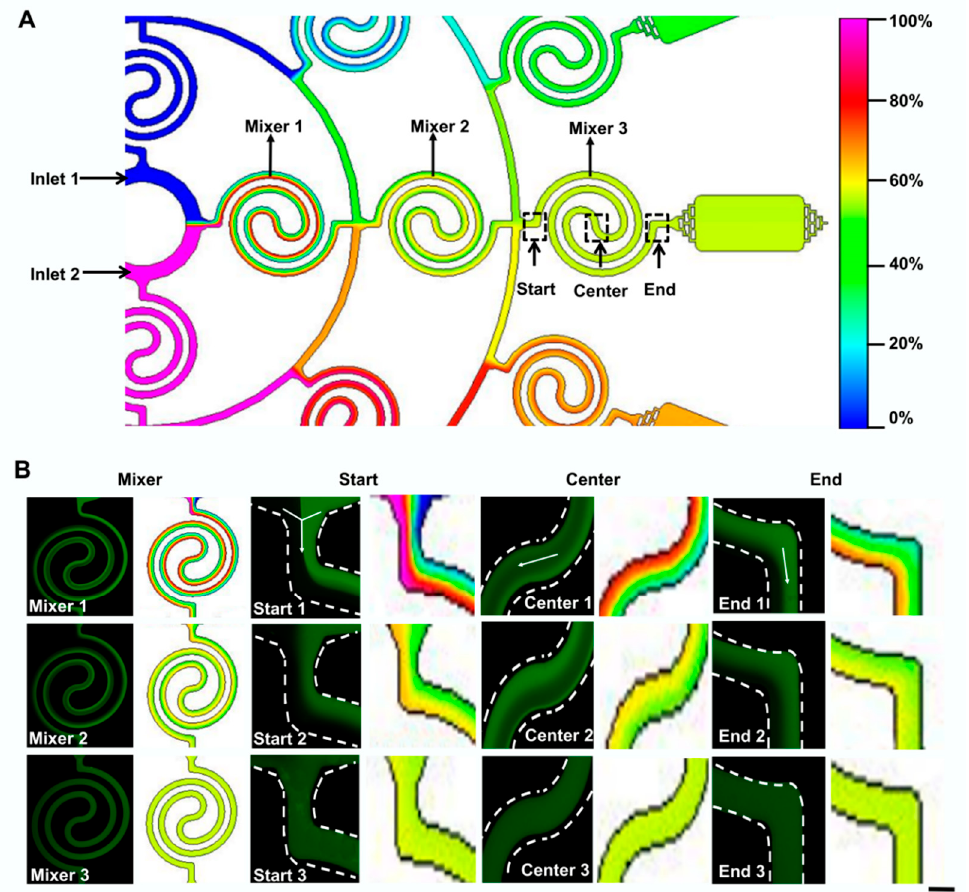
Figure 2. Mixing effect of the designed microfluidic device with successive spiral mixer regulations at a flow rate of 20 μ L·min − 1 . ( A ) Simulation imaging of the microfluidic device. Three areas (start, center, and end) in three spiral mixers were used to identify the mixing status. ( B ) Fluorescence and simulation images of different regions of three spiral mixers. Every two adjacent white dotted lines delineate the boundary of the microchip. Scale bar, 150 μ m.